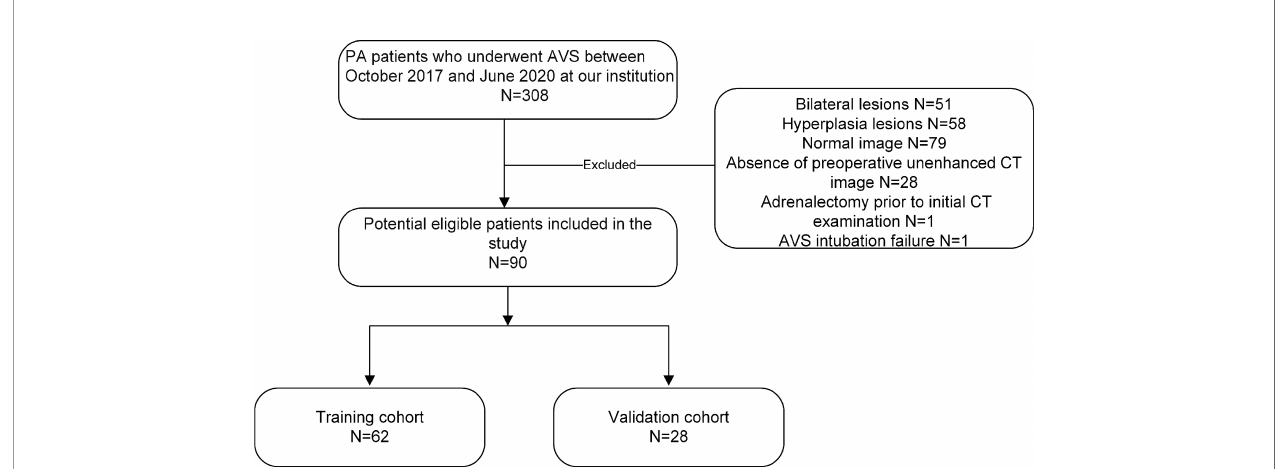
FIGURE 1 | The patient enrollment pathway, along with the inclusion and exclusion